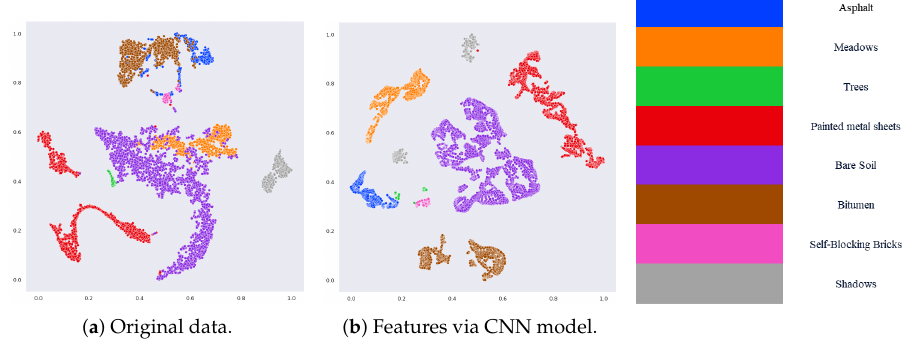
Figure 11. Visualization of the data points of the University of Pavia dataset. Using t-SNE, we reduced the feature dimensionality to 2.